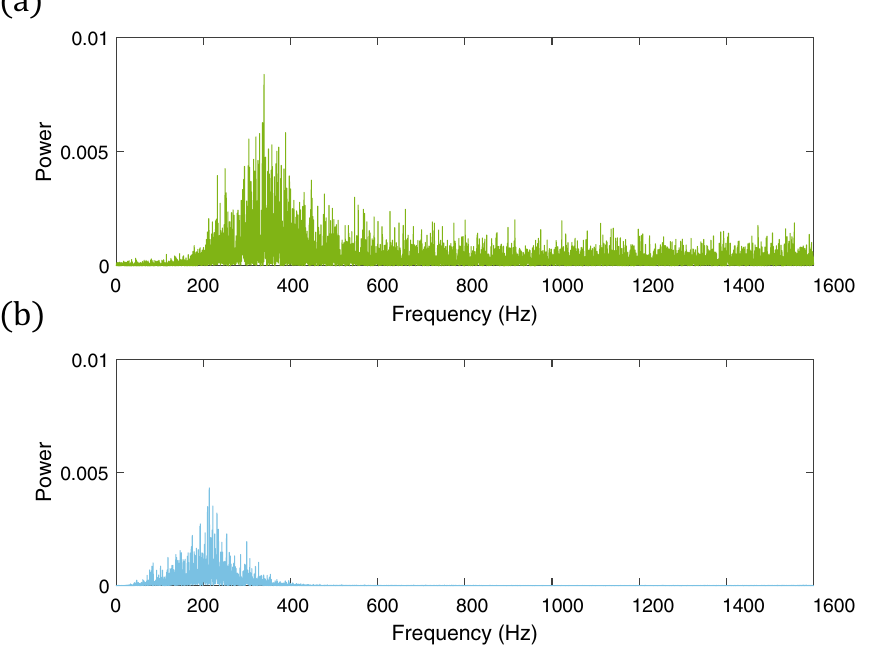
Figure 3. Power spectrum of the measured acceleration corresponding to the ( a ) wide and ( b ) narrow bandwidth mechanical noises.